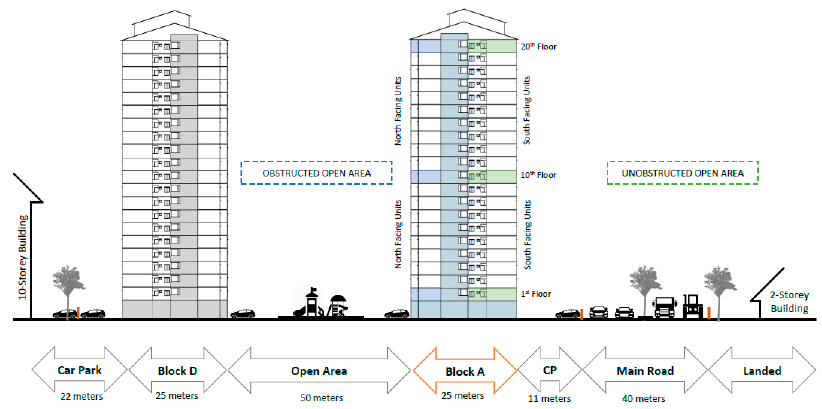
Figure 8. Site section of the PPR Seri Aman.